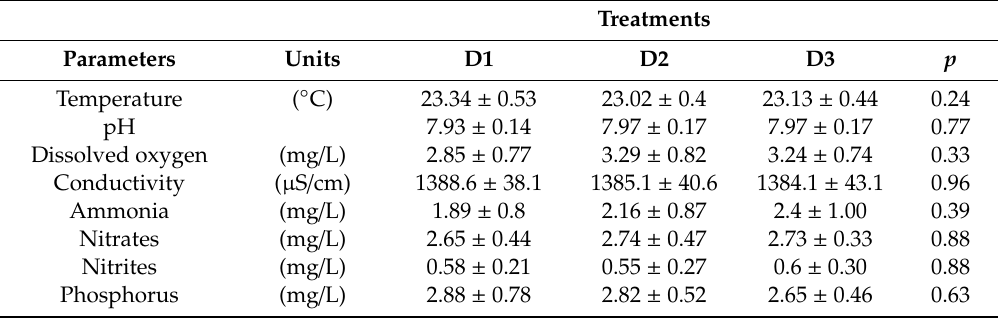
Table 1. Water quality parameters in fish tanks. All values are mean ± standard deviation obtained from three